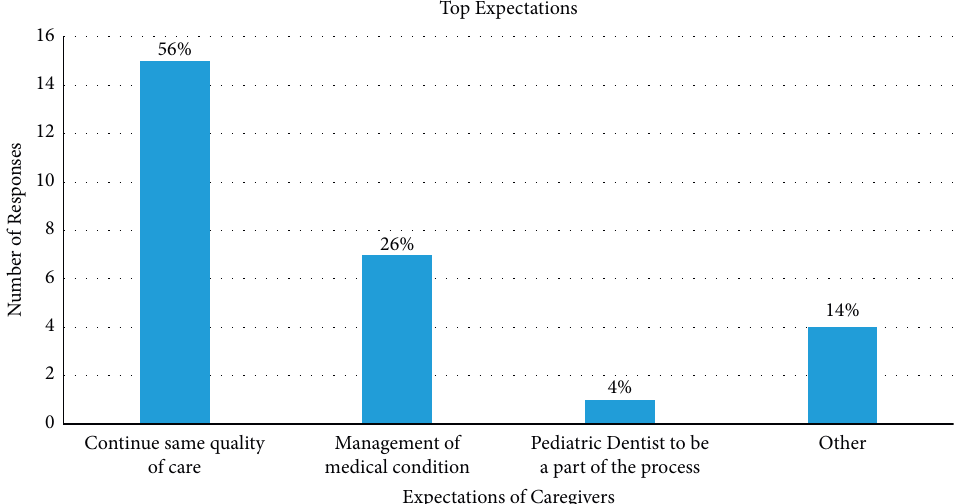
Figure 1: Expectations and percentages of caregivers in response to the transitioning